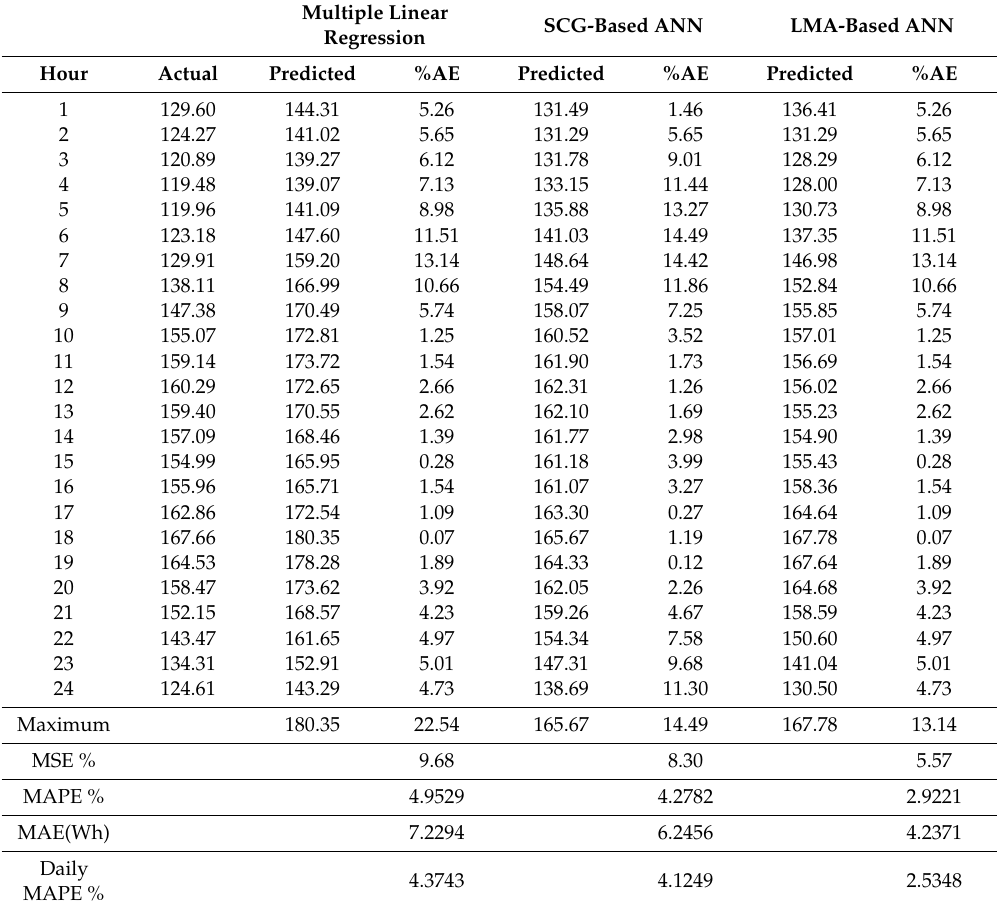
Table 2. Comparisons of performance assessment indices for multiple linear regression SCG and LMA-based ANN